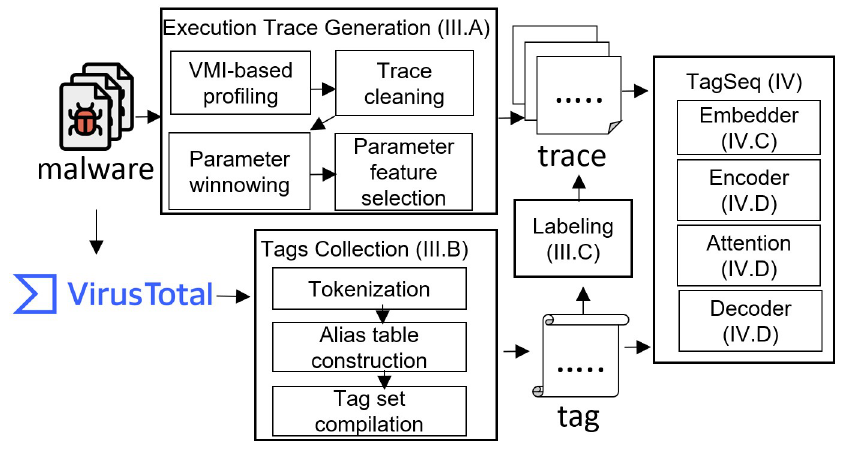
Fig 2. The workflow of TagSeq